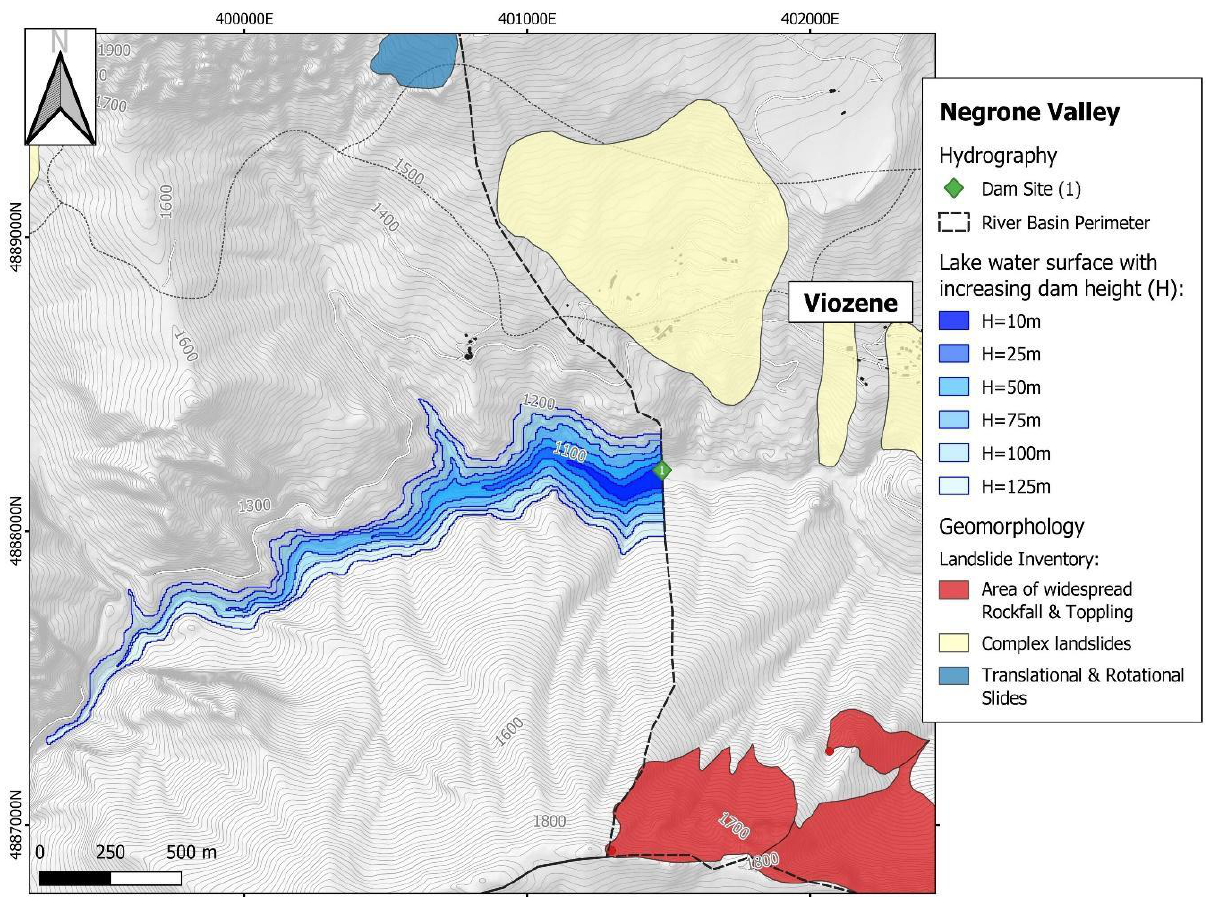
Figure 5. Surface of the lake produced by a dam 125 m-high located at site 1: note that there are no interactions with anthropic structures or known landslides according to [21].